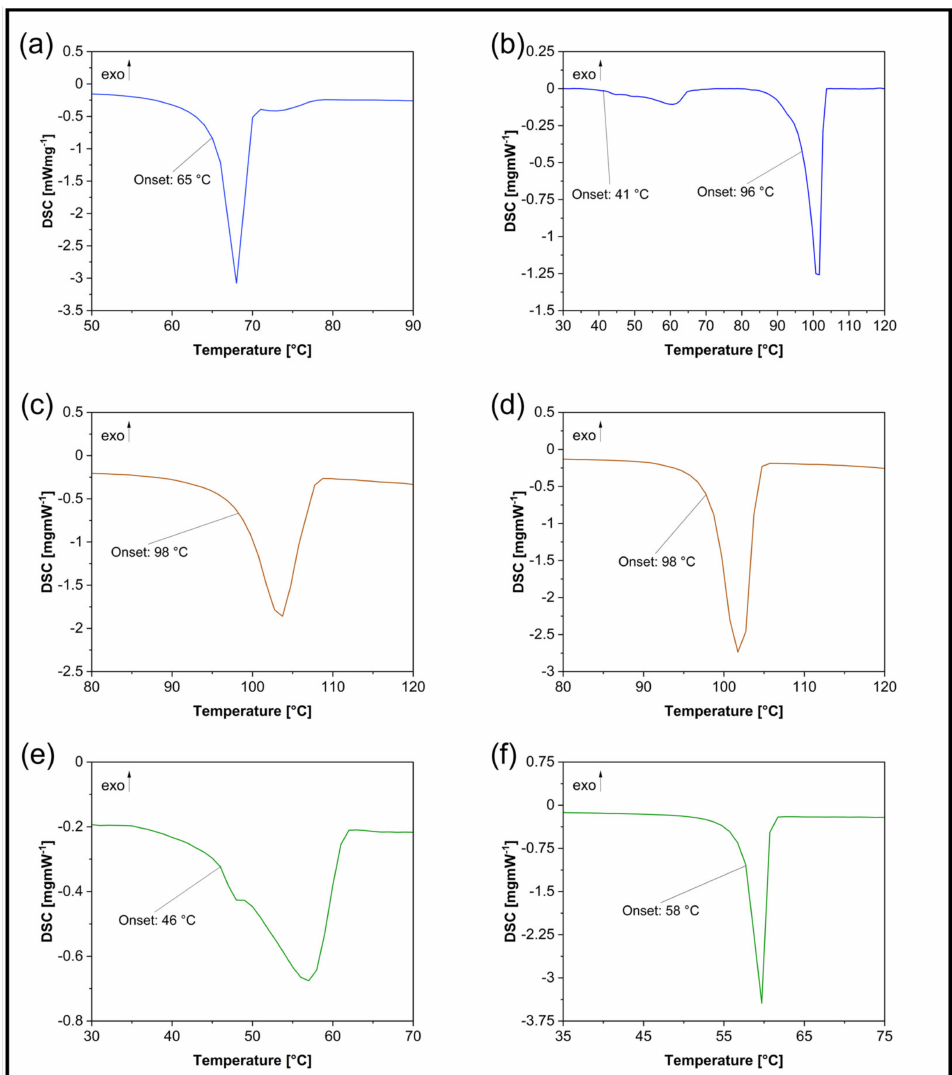
Figure 9. DSC-thermograms of selected MA systems: 2-MA • H 2 O synthesized from solution ( a ), 2-MA obtained mechanochemically ( b ), ( rac )-3-MA synthesized from solution ( c ), and mechanochem- ically ( d ), ( S )-3-MA • H 2 O synthesized from solution ( e ), and via grinding ( f ). For a better visibility, only the relevant temperature range is